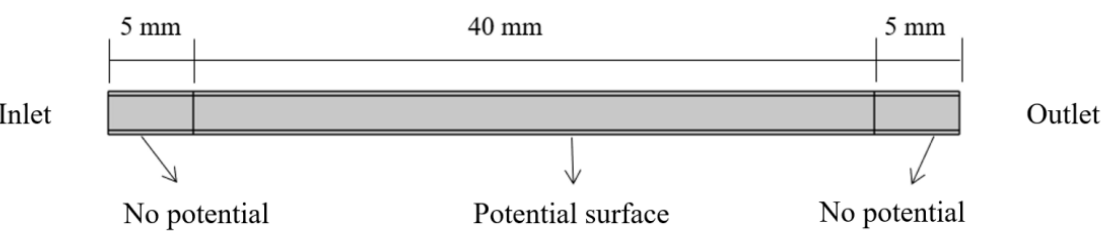
Figure 3. Schematic diagram of the single channel simulation geometric model. Table 1. Constants used in the single channel